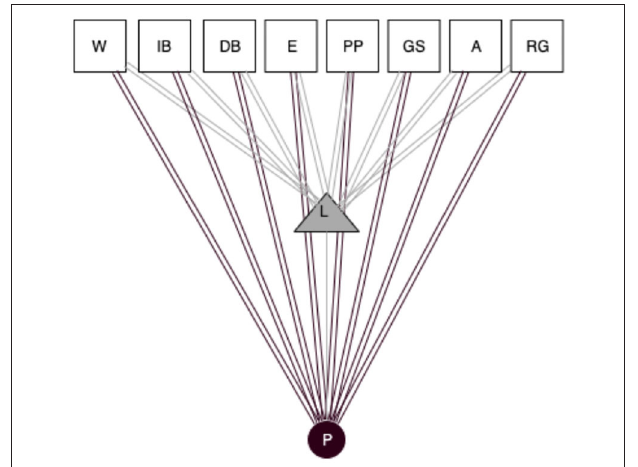
FIGURE 6 | Socio-material network of Patrizio. Circle, actors (P, Patrizio); Triangle, analog objects (C, Computer); Squares, digital objects (W, Word; IB, Internet Browser; DB, Databases; E, Excel; PP, PowerPoint; GS, Google Scholar; A, Academia; RG, ResearchGate); Gray lines, usage of analog objects; Black double lines, usage of digital objects; Gray double lines, analog/digital links.